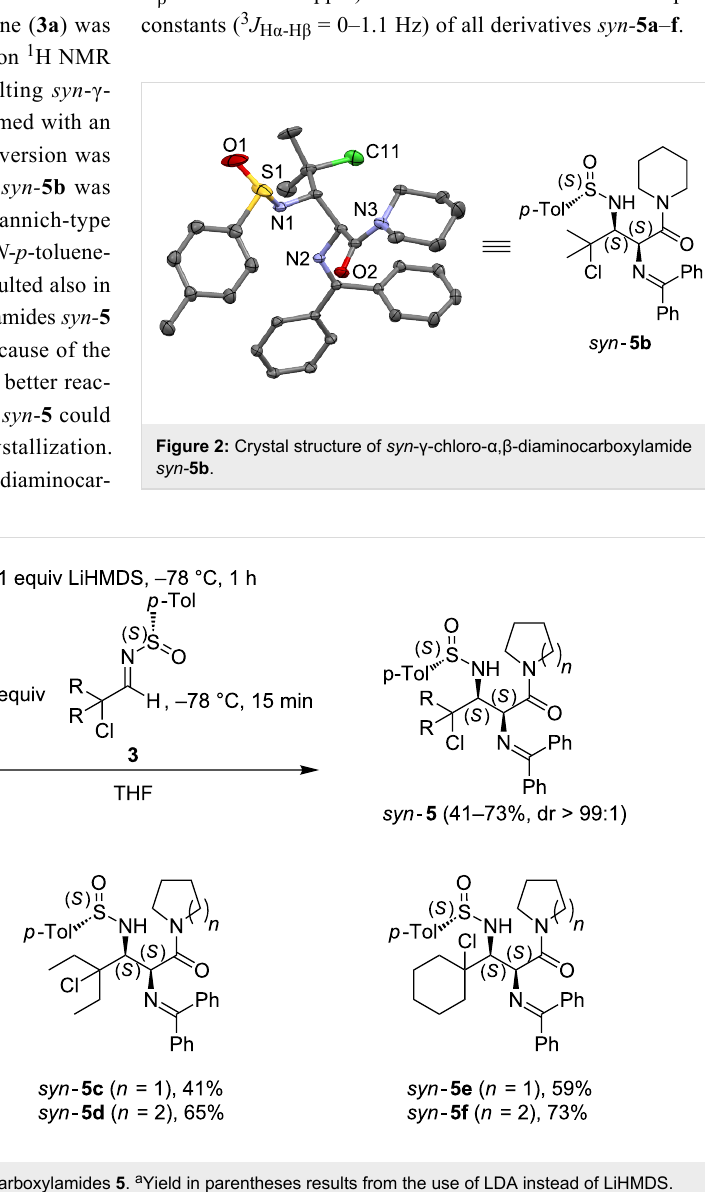
H β : δ = 3.74–4.05 ppm) and the characteristic vicinal